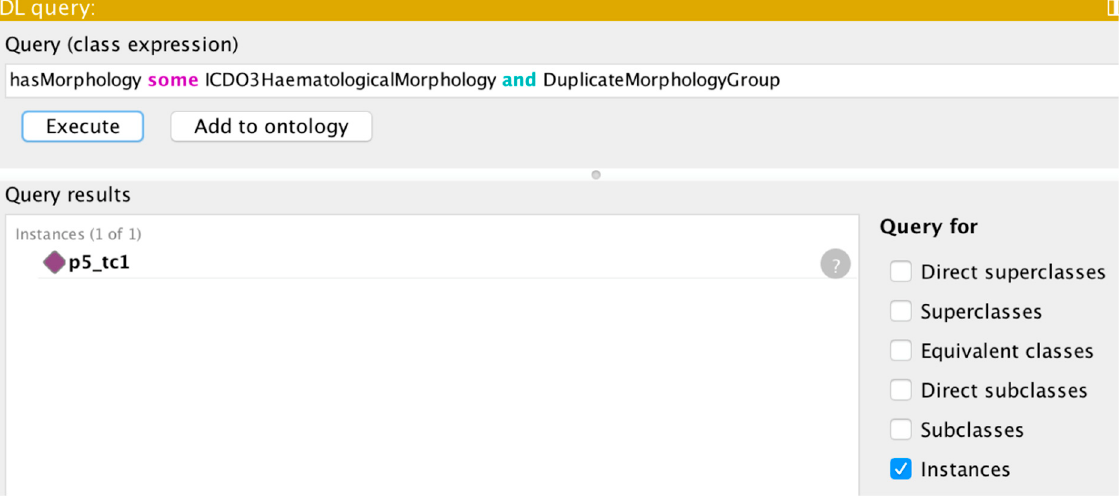
Figure 13. DL query for tumour couplets with haematological morphologies in a common group. The reasoner has found one such case–p5_tc1, with the explanation provided in Figure 14.